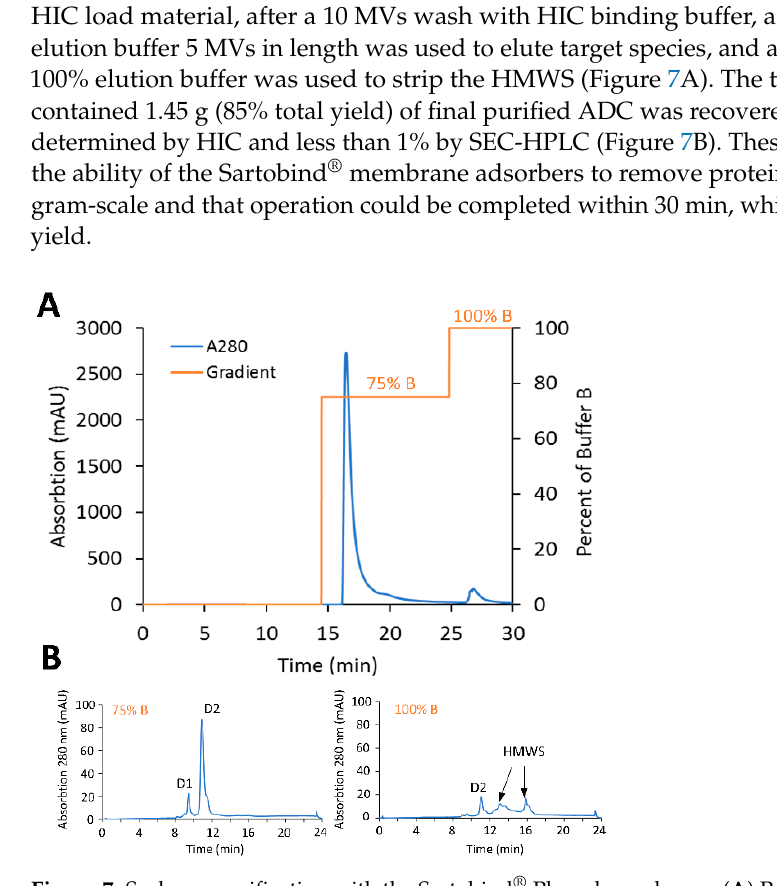
Figure 7. Scale-up purification with the Sartobind ® Phenyl membrane. ( A ) Purification of engineered Cysteine-mAb-PBD ADC using Sartobind ® Phenyl in the stand-alone model. The Sartobind ® S purified material (gram-scale) was loaded to a 150 mL Sartobind ® Phenyl membrane then targeted, and undesired ADC species were eluted sequentially. ( B ) HIC profile of 75% B purified ADC. The HMWS was flushed out with 100% B.